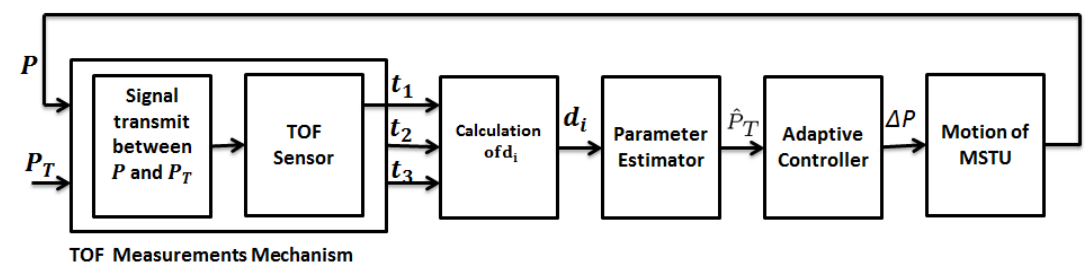
Figure 2. Block diagram of the proposed adaptive lateral target tracking control